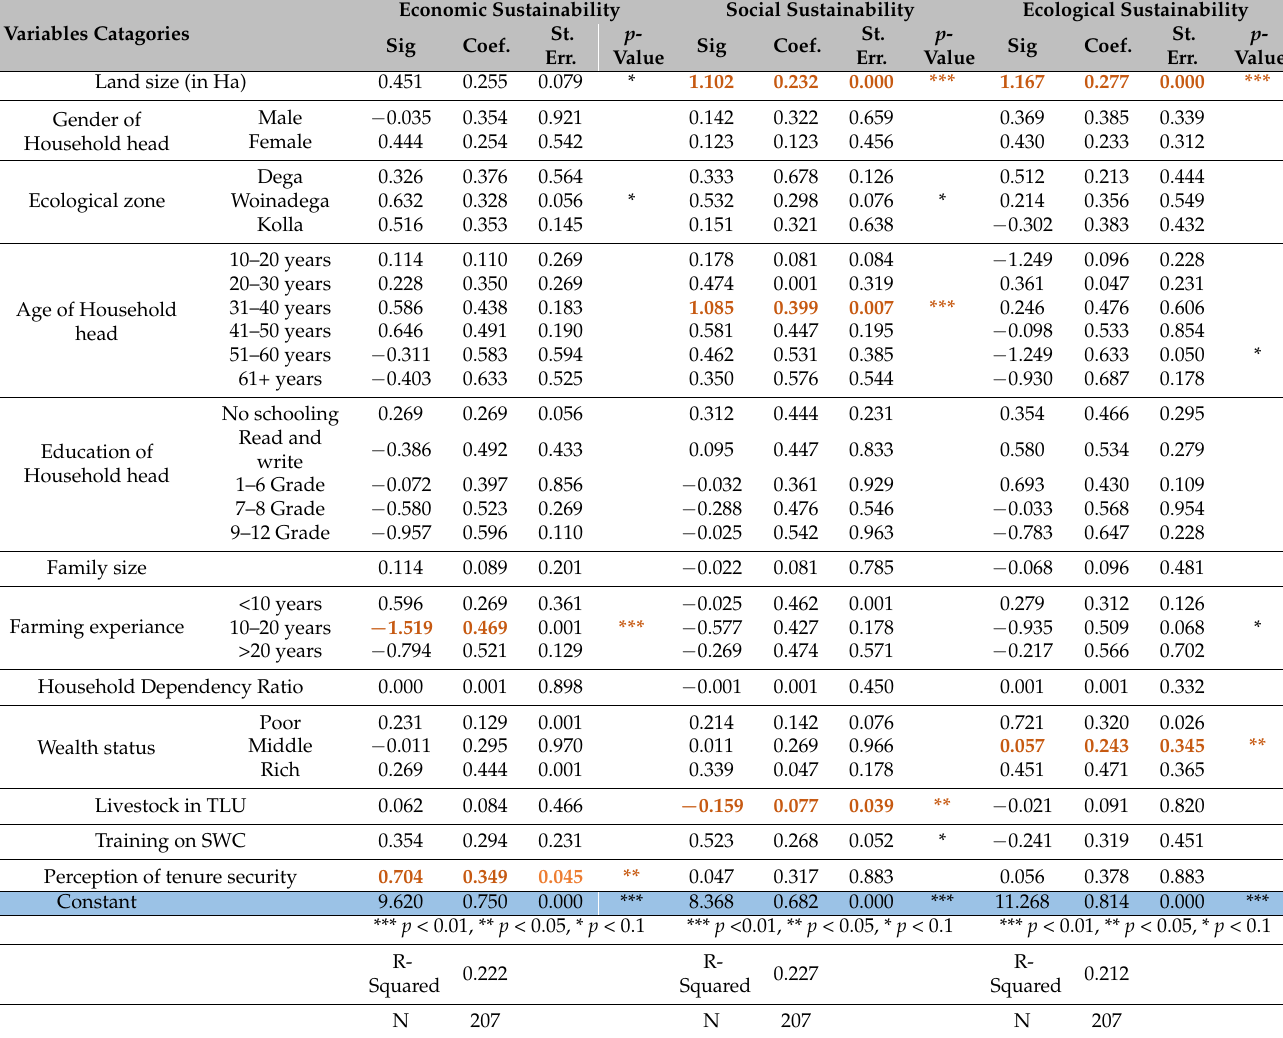
Table 6. Correlations between household variables and the sustainability of physical